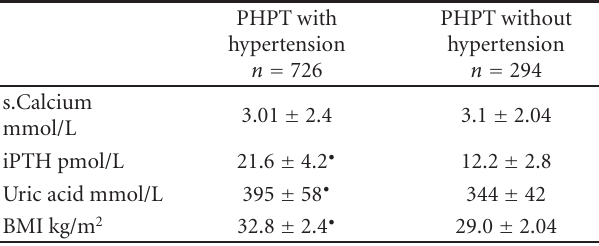
Table 4: Comparison of biochemical data and BMI in hypertensive patients with PHPT and normotensive patients with PHPT. Results are presented as mean values ± SD. (cid:129) P < . 01—patients with PHPT and hypertension versus patients with PHPT without